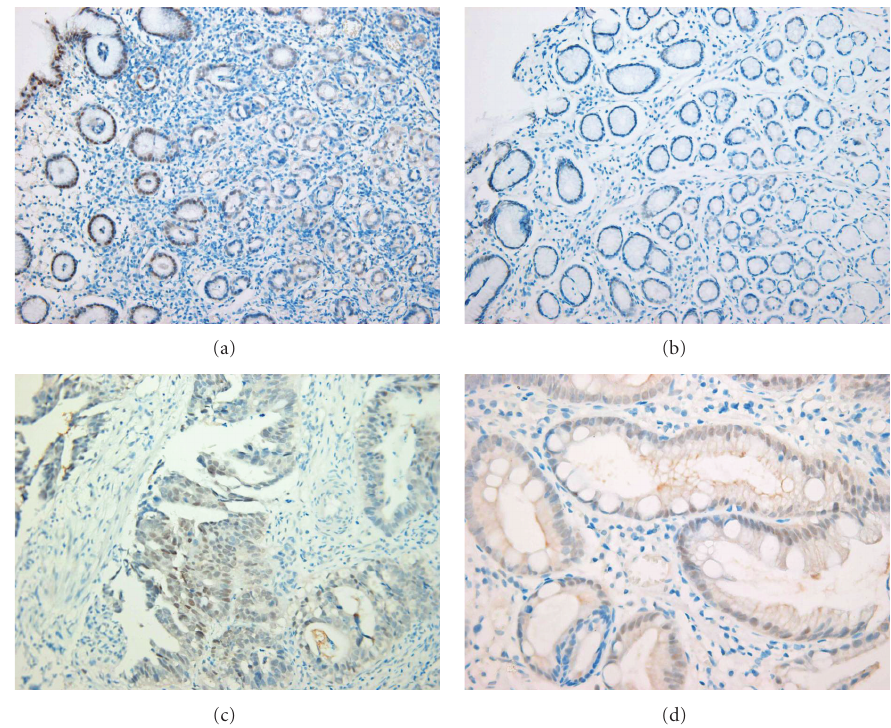
Figure 2: PPAR γ protein expression in various tissues. Strong nuclear staining in gastric epithelial cells of H. pylori -infected patients (a) and weak nuclear staining in H. pylori -negative subjects (b). PPAR γ protein is also expressed in the nucleus of tumor cells in gastric adenocarcinoma (c) and in noncancerous tissue with intestinal metaplasia adjacent to cancer tissue